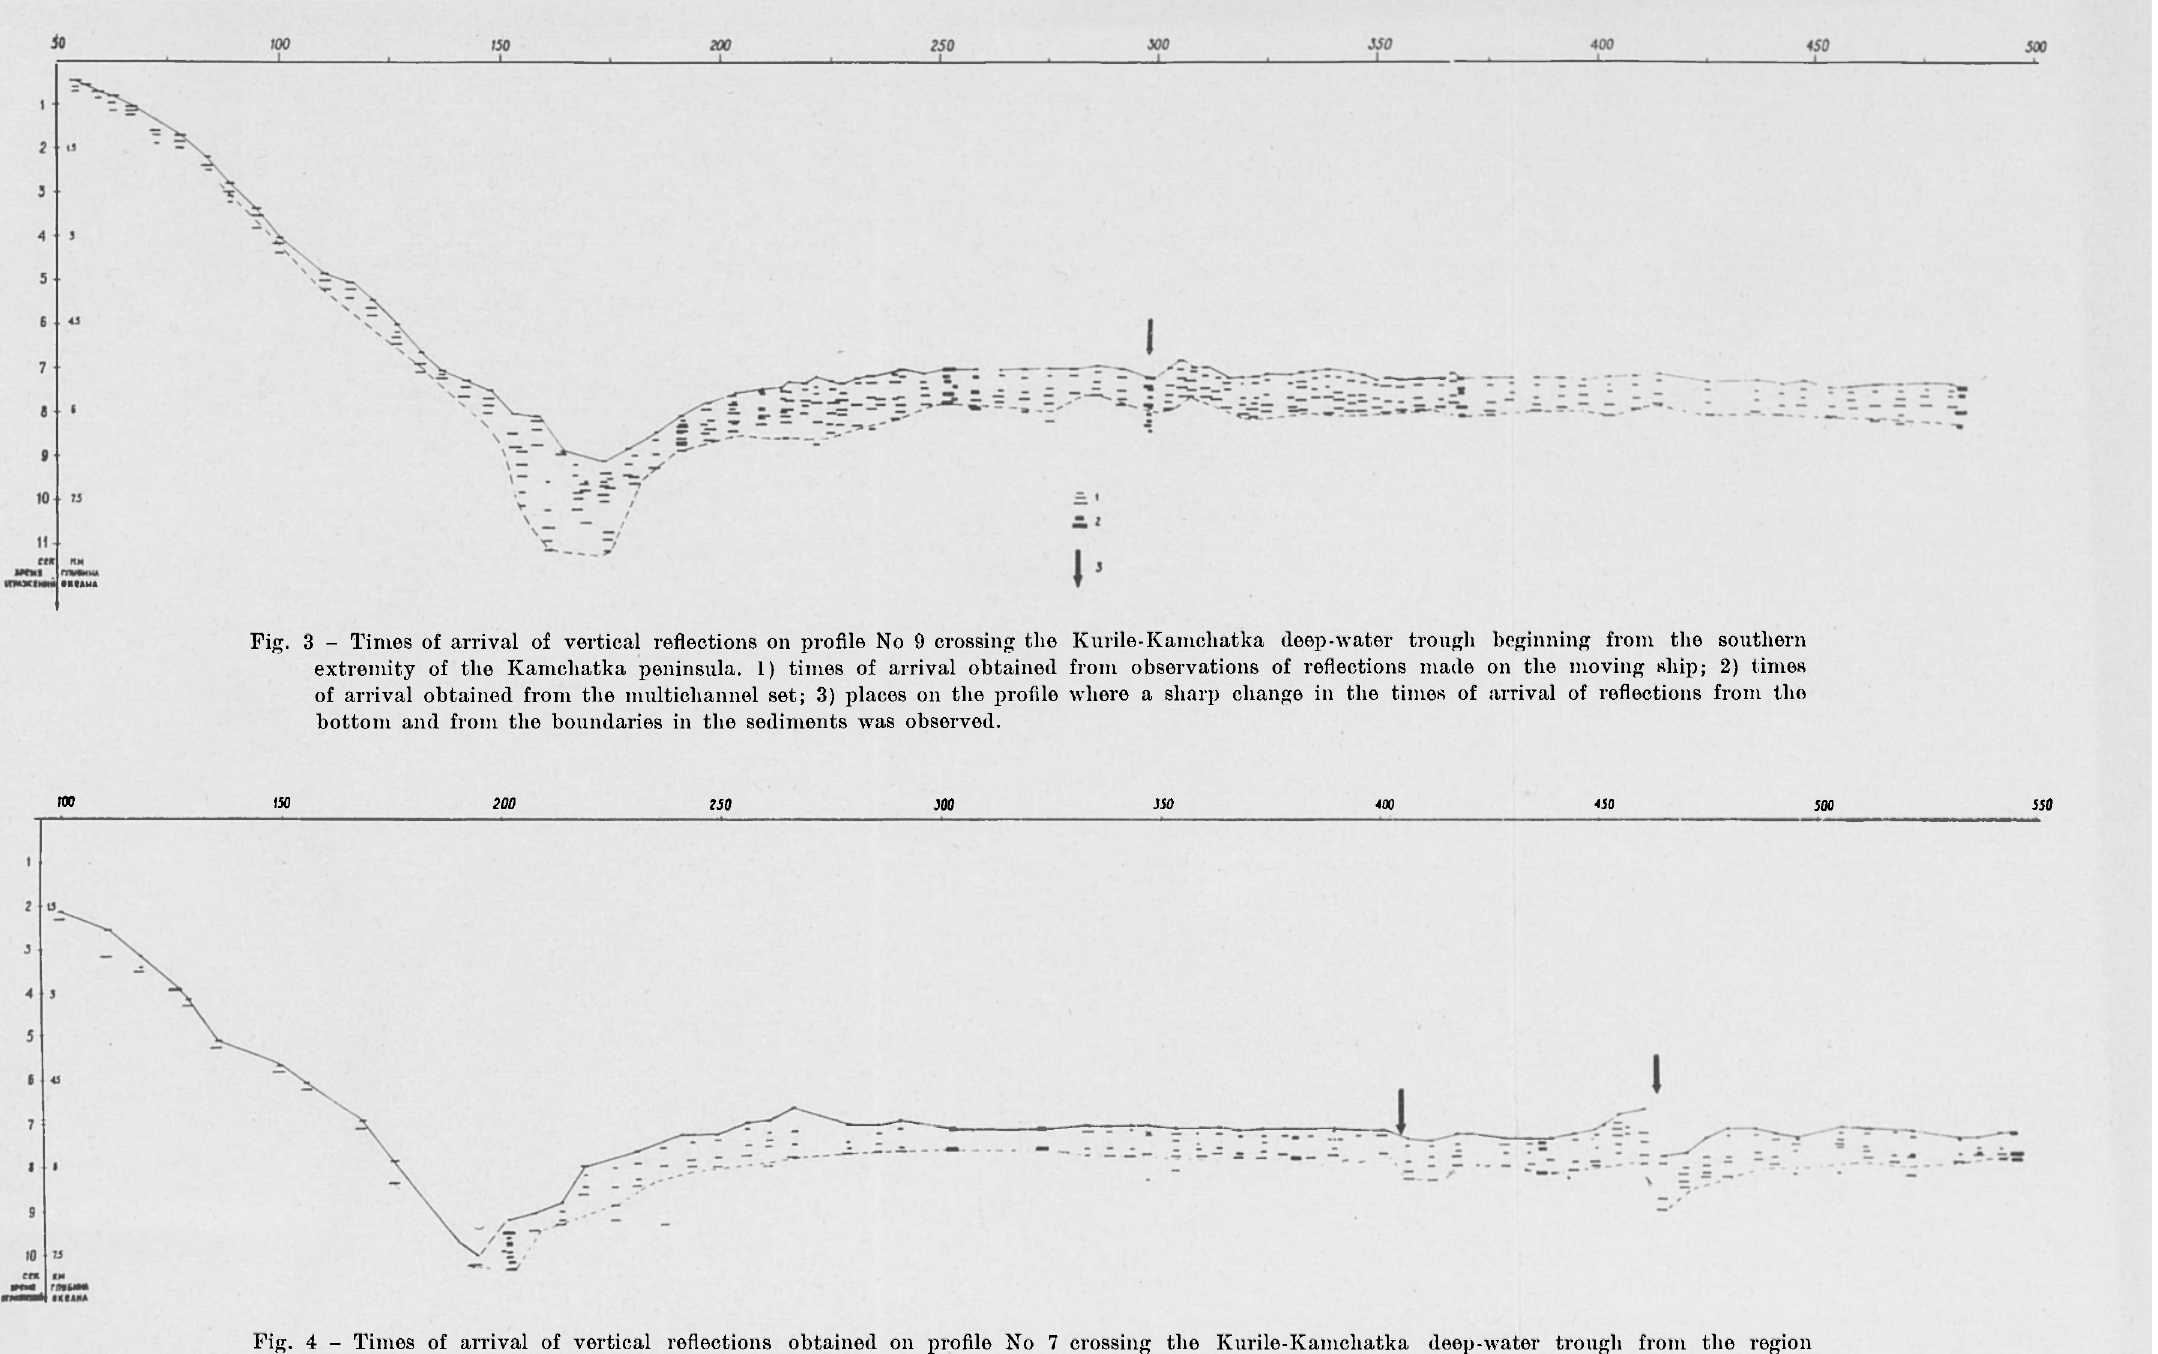
Pig. 3 - Times of arrival of vertical reflections on profile No 9 crossing the Kurile-Kamchatka deep-water trough beginning from the southern extremity of the Kamchatka peninsula. 1) times of arrival obtained from observations of reflections made on the moving ship; 2) times of arrival obtained from the multichannel set; 3) places on the profile where a sharp change in the times of arrival of reflections from the bottom and from the boundaries in the sediments was observed.